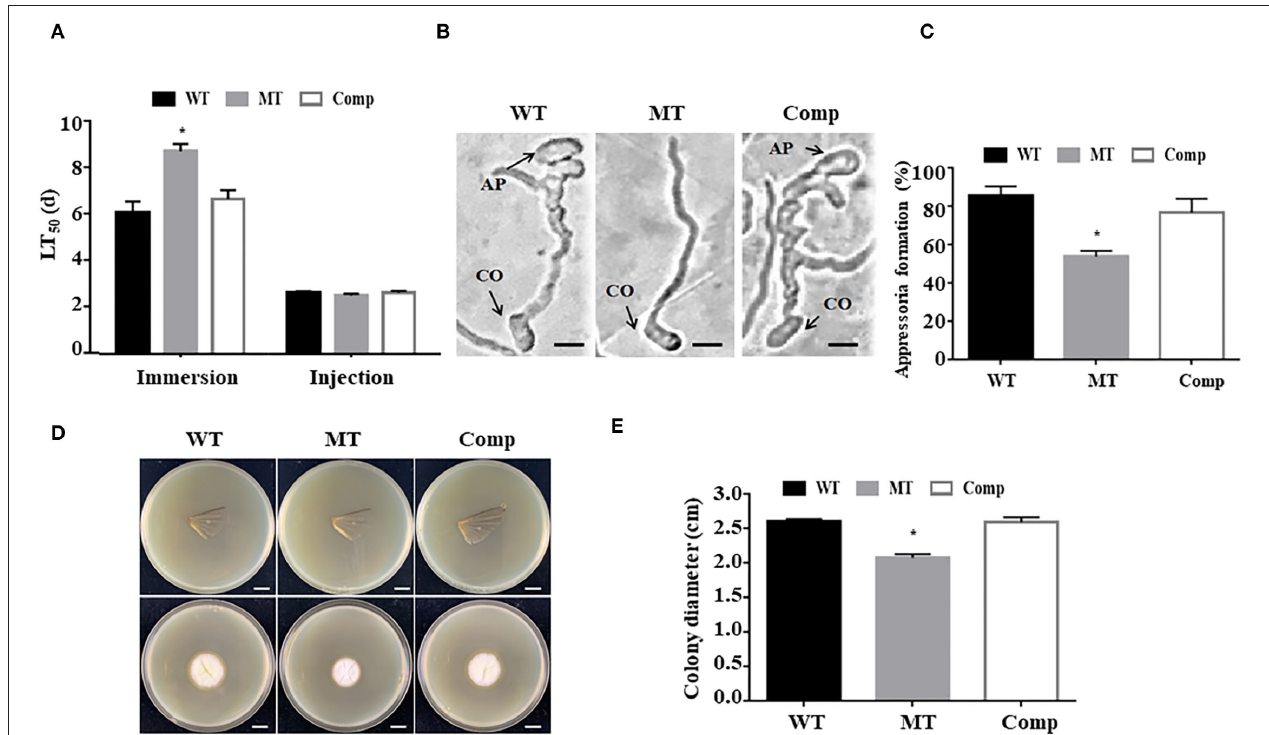
FIGURE 4 | Effect of MrUbp14 disruption on fungal virulence. (A) The median lethal time (LT 50 ) (days) of different strains after topical inoculation and direct injection. (B) The images of appressorium formation generated on cicada wings. Scale: 10 µ m. CO, conidium, AP, appressorium. (C) The percentage of appressorium formation generated on cicada wings. (D) The colony growth was measured after the removal of the cicada wings and incubation at 25 ◦ C for 5 days. Scale: 1cm. (E) The colony diameters of relative strains cultured in the (D) section. Error bars indicate SD of three biological replicates. The asterisk (*) indicates p <